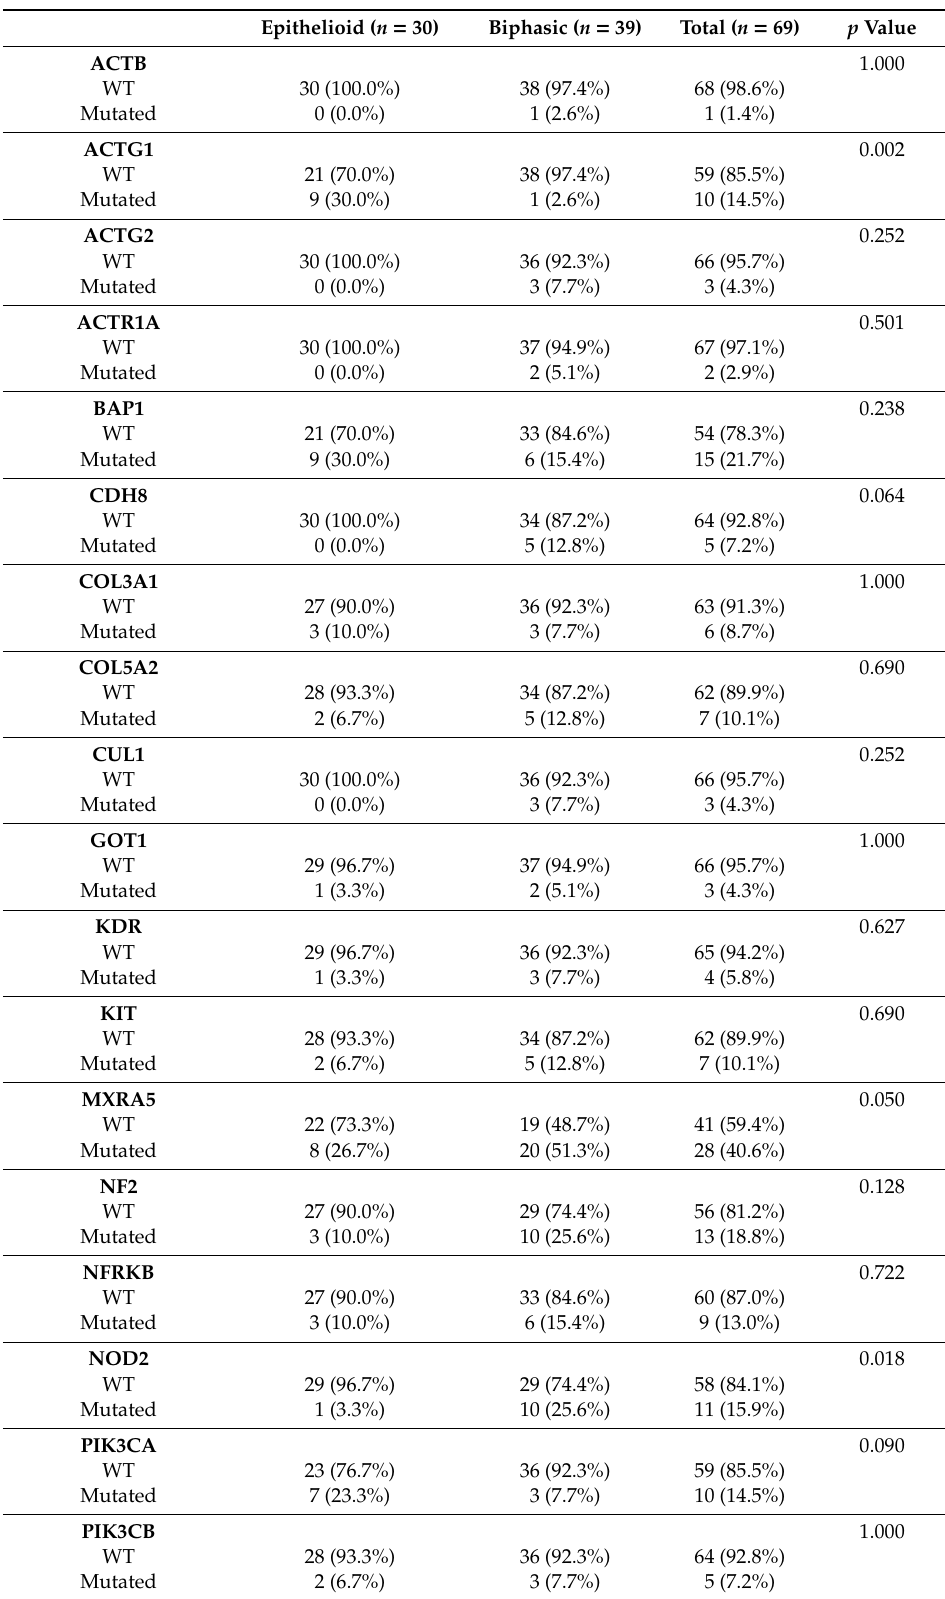
Table 2. Comparison of genes mutation frequencies in epithelioid and biphasic mesotheliomas. WT: Wild